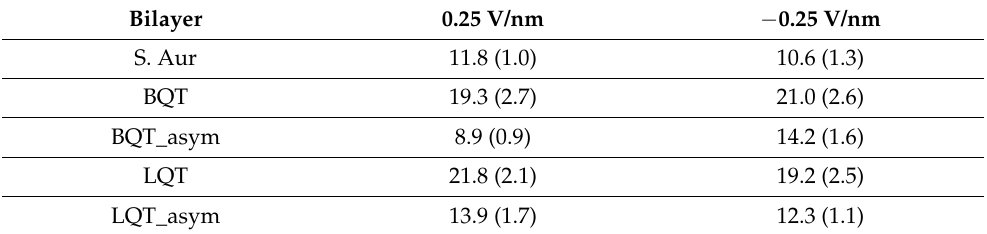
Table 2. Mean time (ns) for a pore to form in the different bilayers at the two opposite applied electric